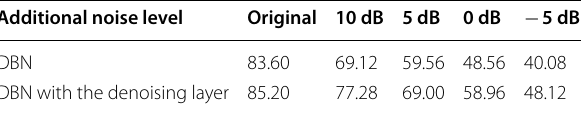
Table 2 Classification accuracy of the DBN based experiment (%) Additional noise level